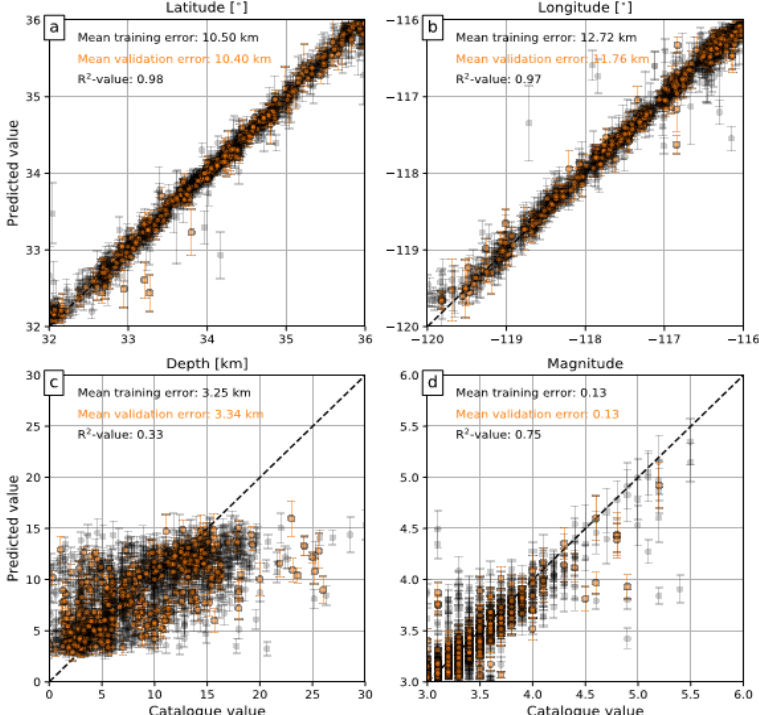
Figure 6. Mean absolute error for training and validation sets obtained from the California dataset. Predicted values by GNN model and the actual values for ( a ) latitude, ( b ) longitude, ( c ) depth, and ( d ) magnitude after inserting geographical information.